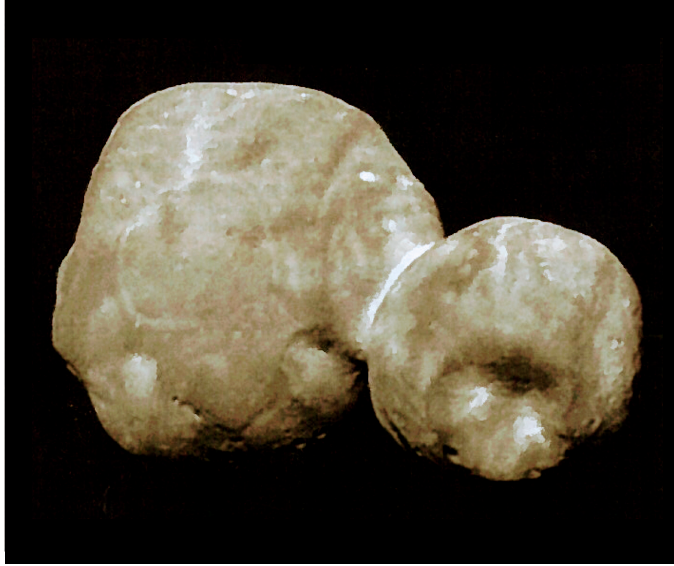
Figure 6. Asteroid 486958-2014 MU69 (photo courtesy of NASA).